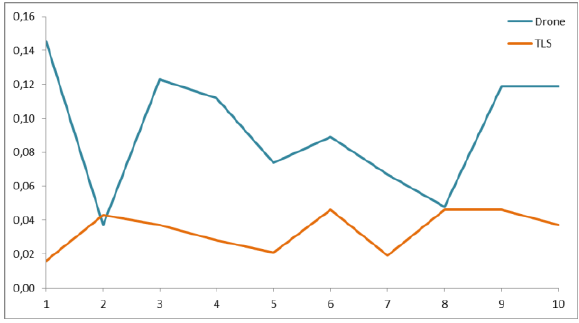
Figure 17. Comparison of the errors (cm) of the two systems